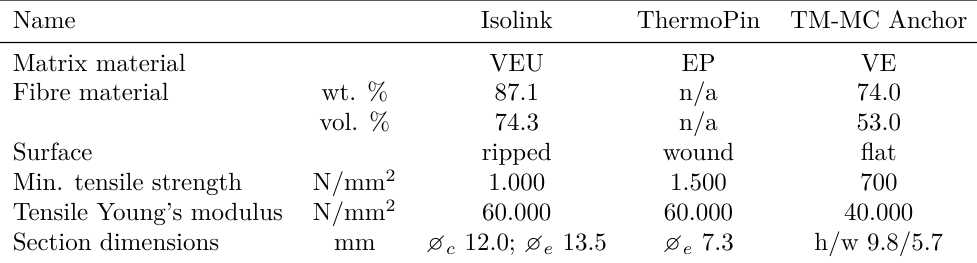
Table 1. Characteristics of GFRP Connectors acc. to [13].